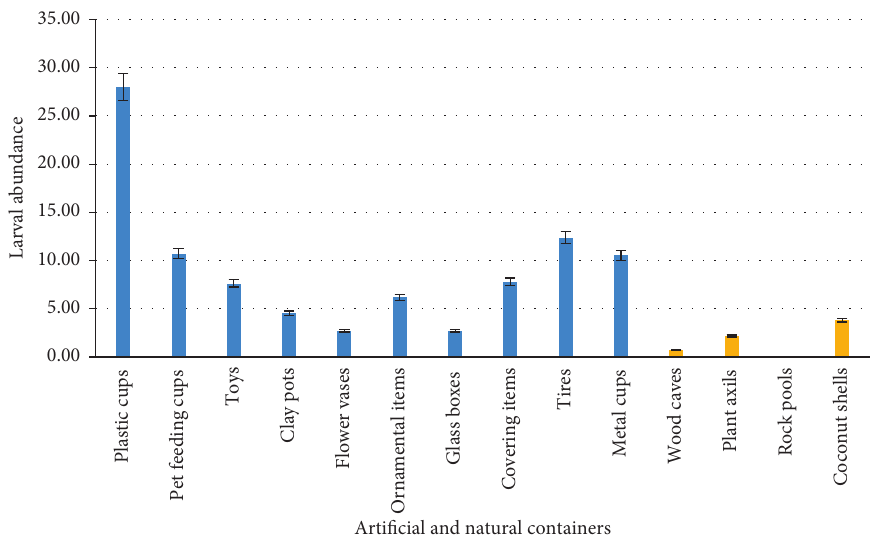
Figure 4: Relative abundance of Aedes albopictus larvae in natural containers and artificial containers.